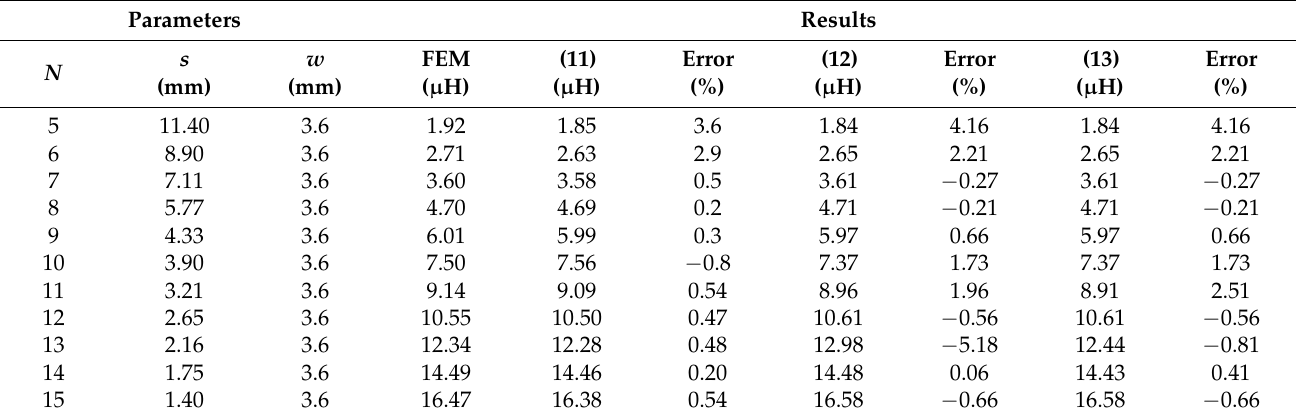
Table 1. Comparison results.